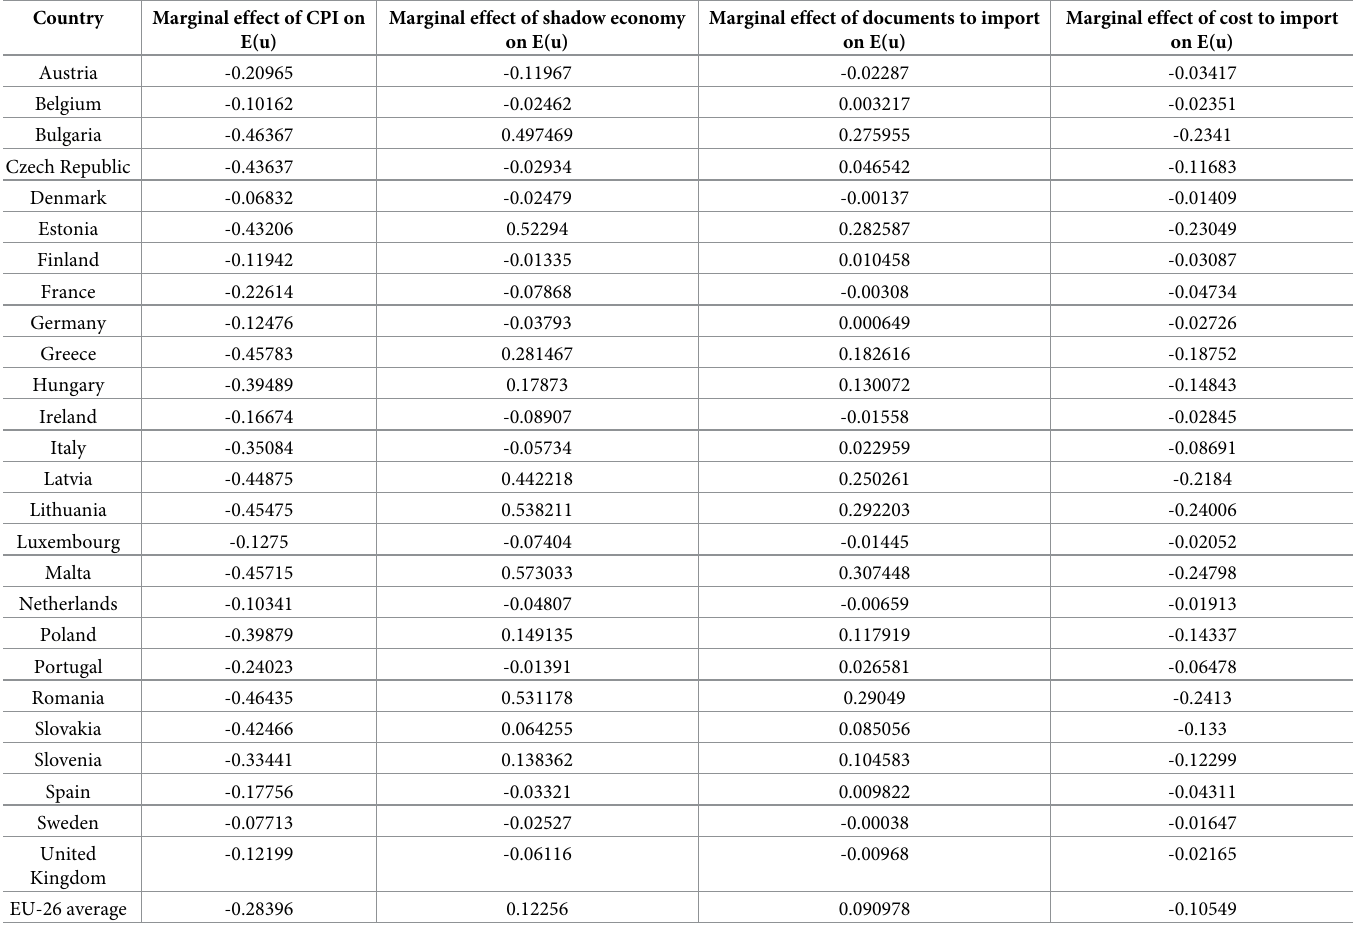
Table 3. The marginal effects of the CPI, shadow economy, documents to import and cost to import on the mean E(u) of the inefficiency term u i , t .